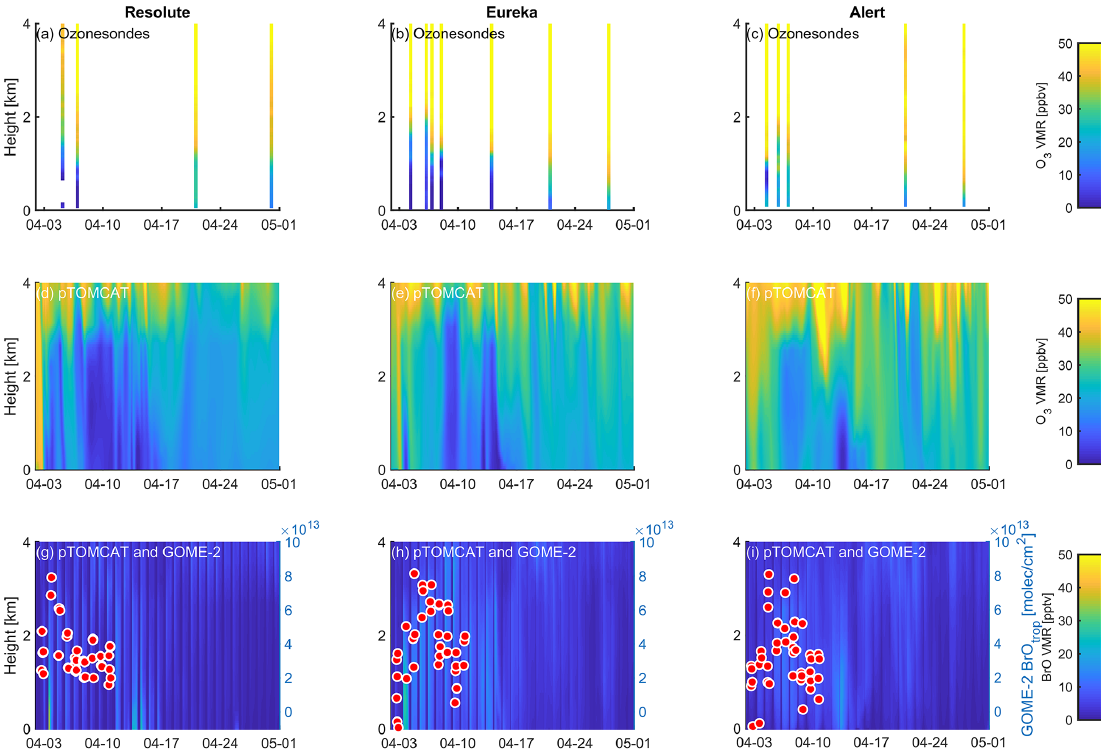
Figure 13. Same as Fig. 12 but for pTOMCAT_control run